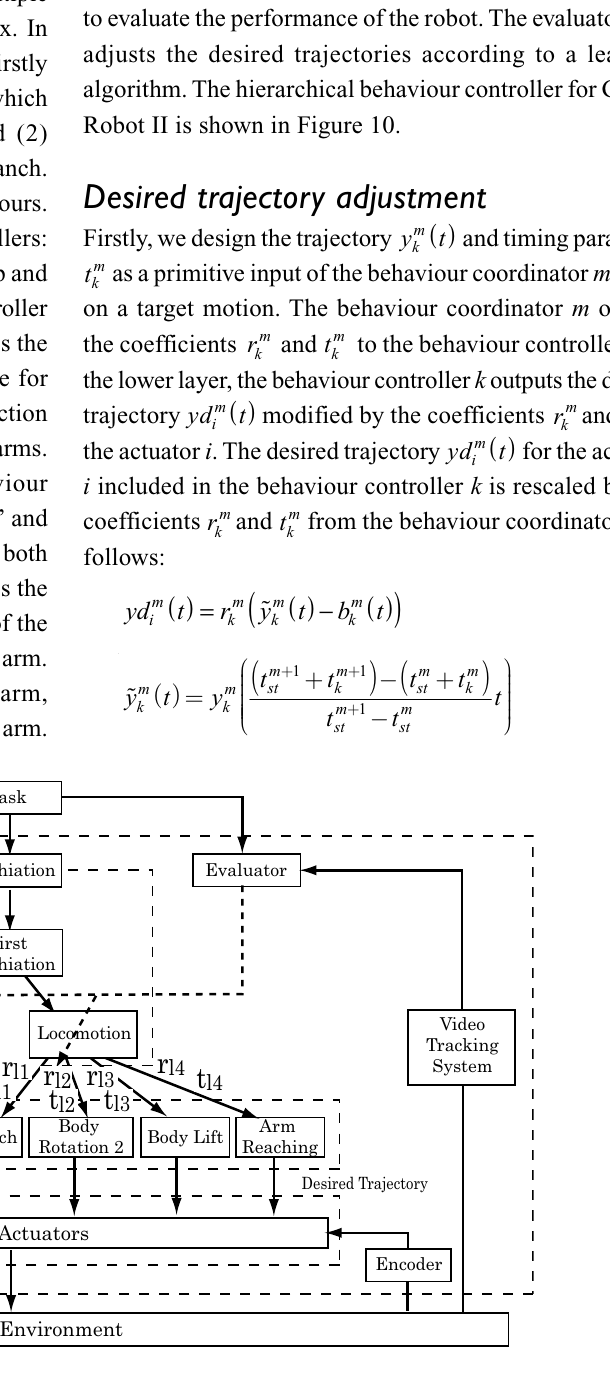
Figure 10 Hierarchical behaviour controller for Gorilla Robot